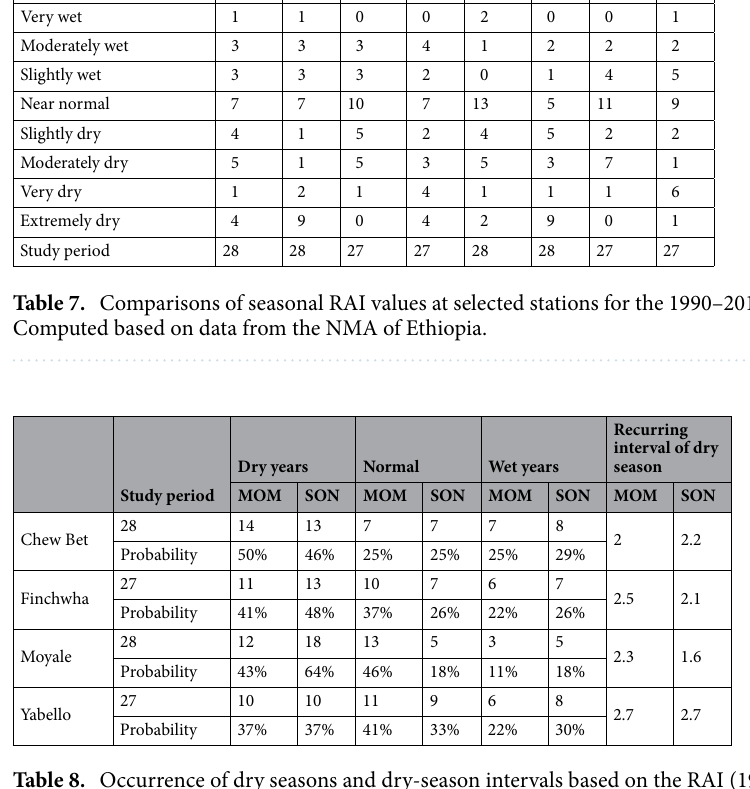
Rainfall condition class